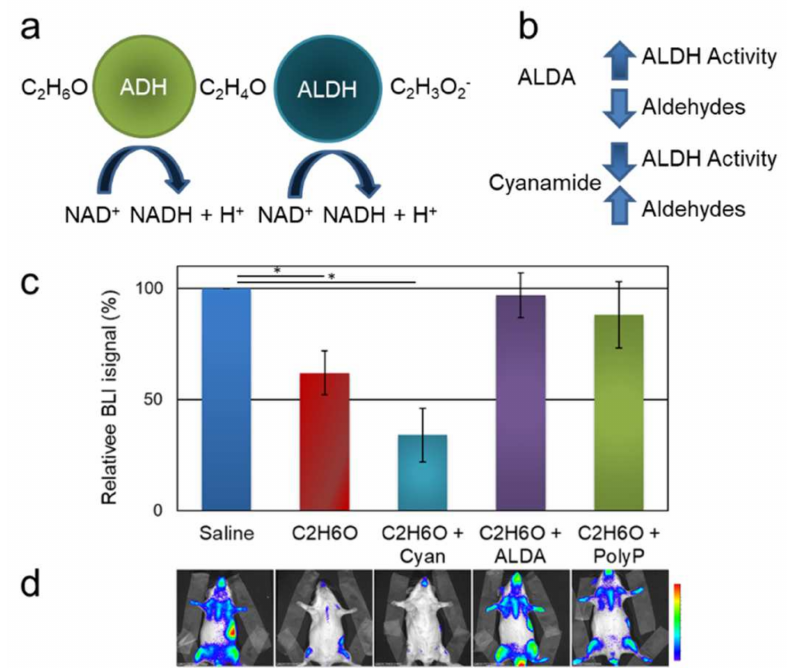
Figure 3. Effects of pharmacological treatments on NF-Y-dependent cell proliferation in MITO-Luc mice administered C 2 H 6 O. ( a ) Illustration of the metabolism of ethanol into acetaldehyde and acetate. ADH: alcohol dehydrogenase; ALDH: aldehyde dehydrogenase. ( b ) Schematic representation of the effects of pharmacological treatment with the ALDH inhibitor cyanamide or the activator ALDA. ( c ) Quantification of the BLI signals relative to the control (saline) group in animals administered C 2 H 6 O treated either with cyanamide, ALDA, or the antioxidant compound Phenolea Active Com- plex (PolyP). ( d ) Representative BLI analysis in one mouse per group at approximately 10 days after treatment. The pseudo-color scale bar indicates the relative signal intensity from the lowest (blue) to the highest (red) (range 1 × 10 4 –1 × 10 5 photons/s/cm 2 /sr). The asterisk (*) indicates a statistically significant difference between the indicated groups ( p ≤